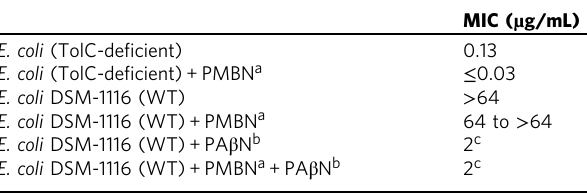
Table 2 MIC of carolacton on Escherichia coli determined